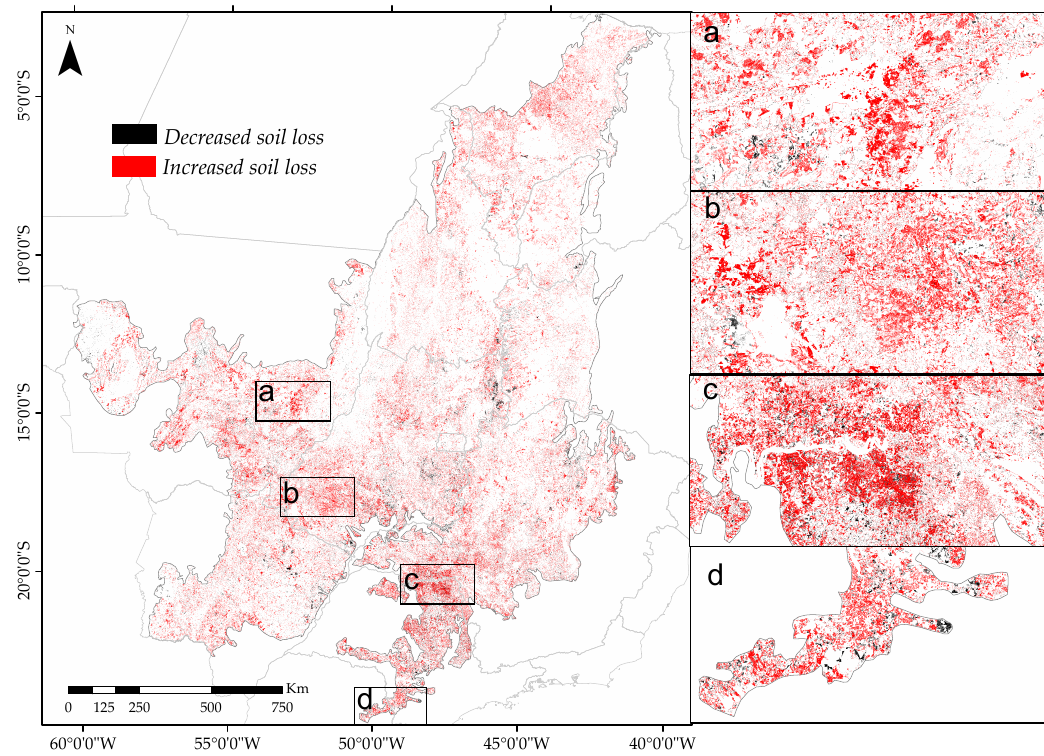
Figure 4. Map of changes in soil loss between 2000 and 2012 in the Brazilian Cerrado. Red areas indicate that soil loss increased from 2000 to 2012, while black areas indicate that soil loss decreased from 2000 to 2012. In both areas a and b , there was a predominance of annual crops expansion; in c area, there was a prevalence of semi-perennial crop expansion; and in d area, there was a predominance of silviculture